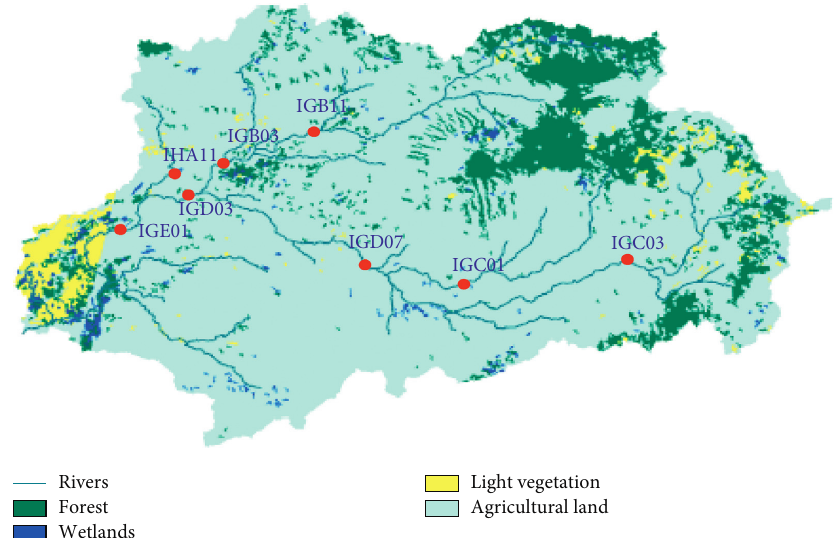
Figure 3: LULC of Nyando River basin in 2008 and the sampling